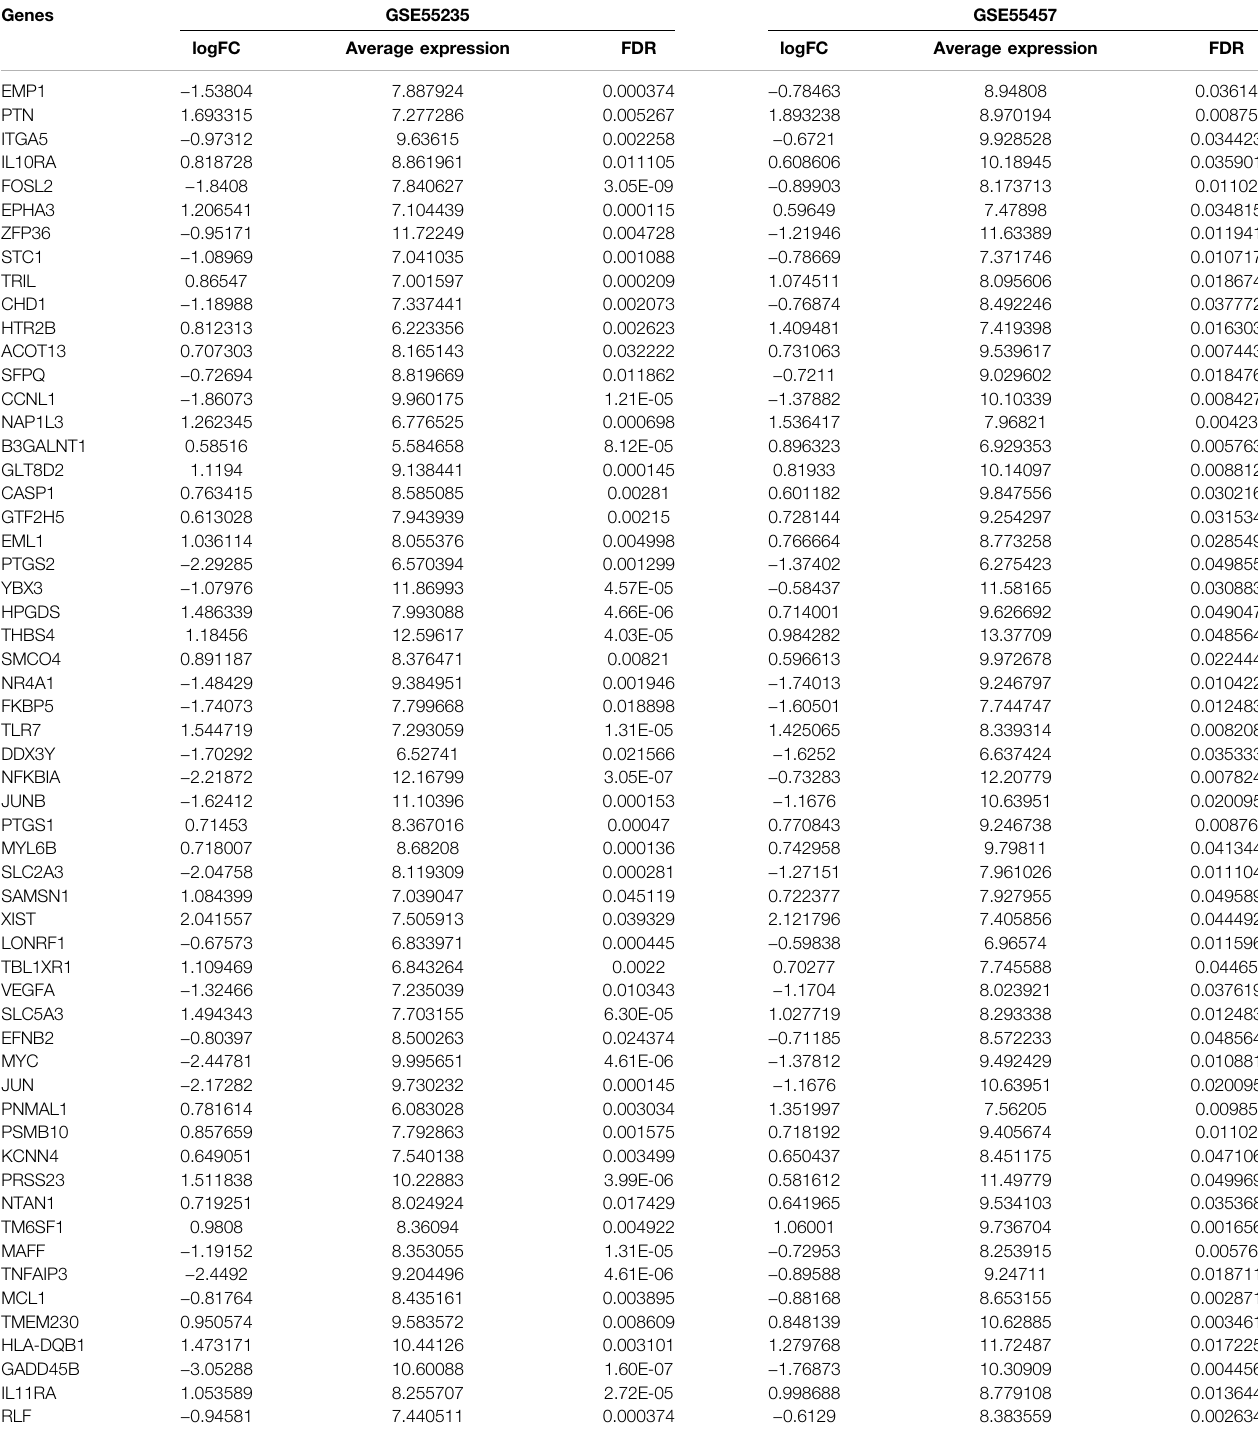
TABLE 1 | 57 common DEGs for OA in the GSE55235 and GSE55457 datasets.